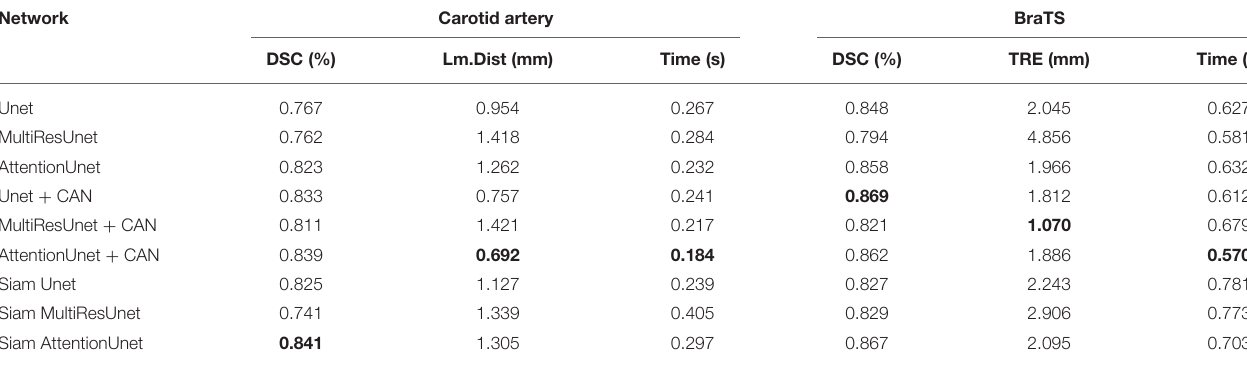
TABLE 2 | Registration performance of different networks on carotid artery and BraTS datasets.